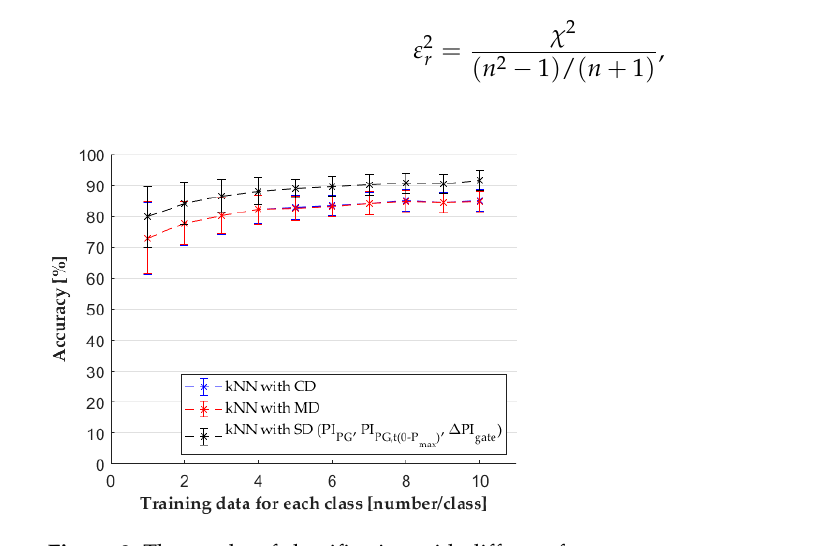
Figure 9. The results of naïve Bayes classifier with the different datasets.